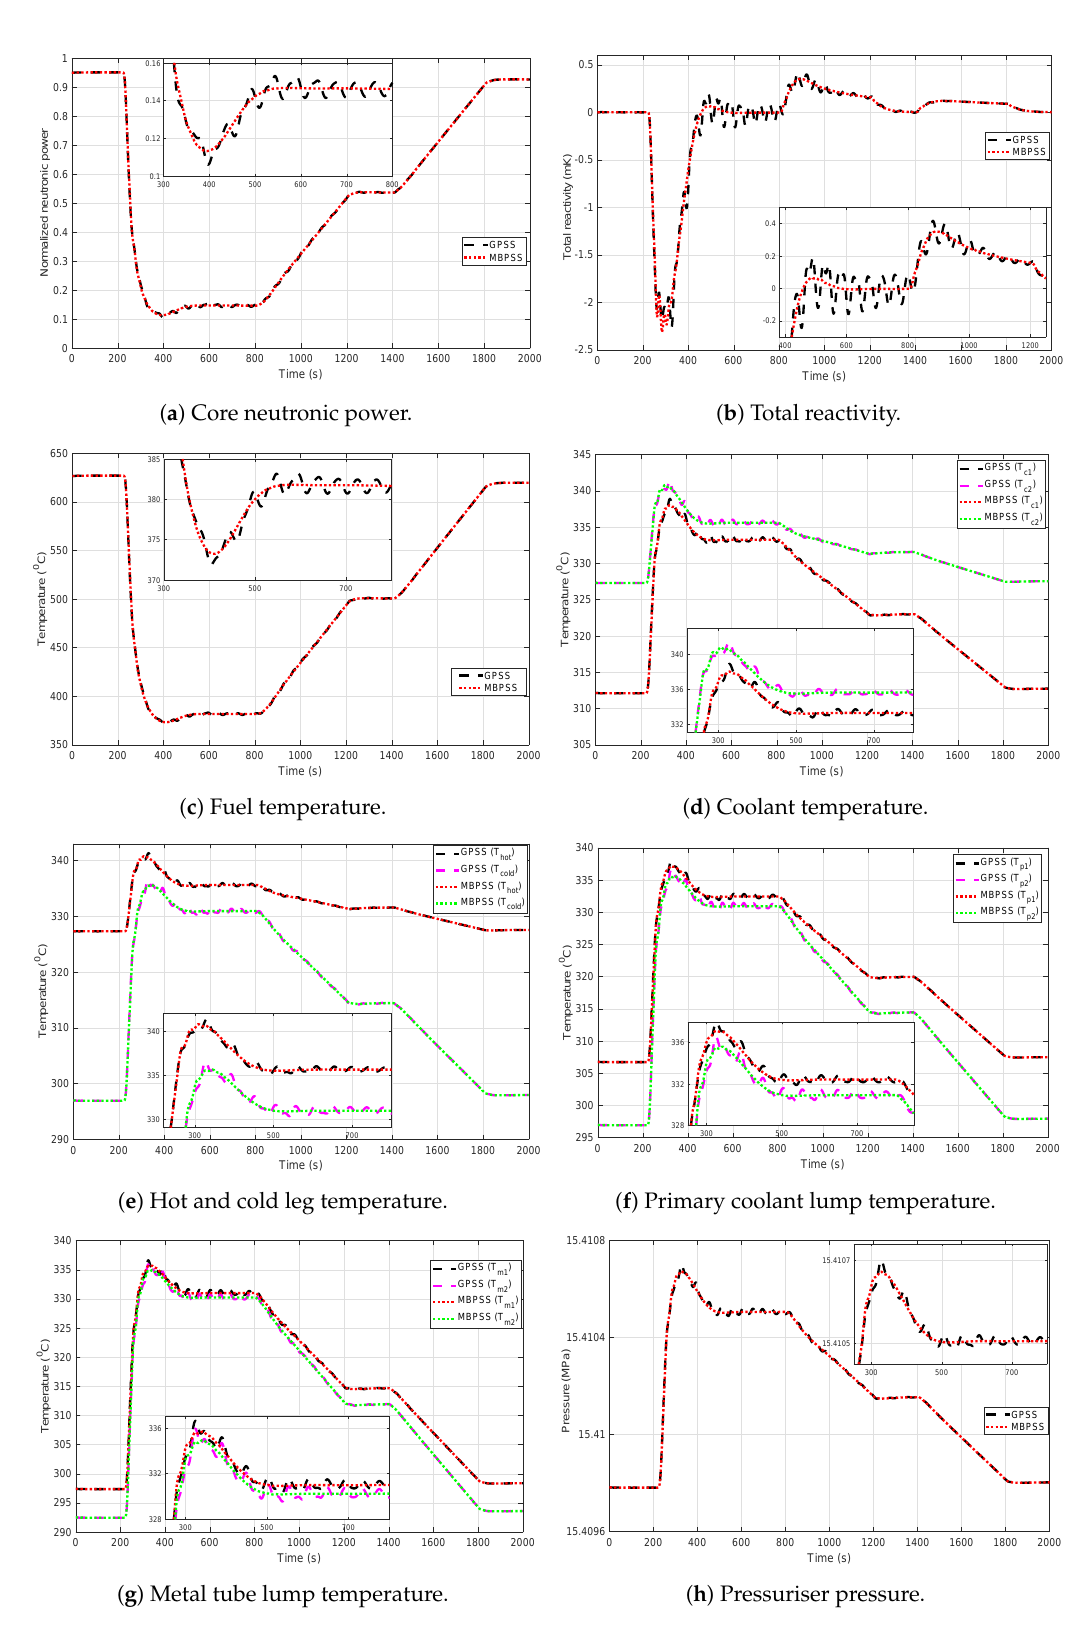
Figure 11. Case II.1: Variation in nuclear power plant variables following three-phase faults with generic and multiband PSS with